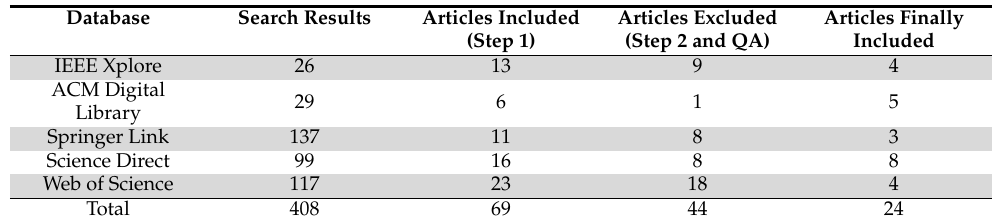
Table 3. Number of studies per database and results after applying inclusion criteria (Step 1), exclusion criteria, and quality assessment criteria (Steps 2 and